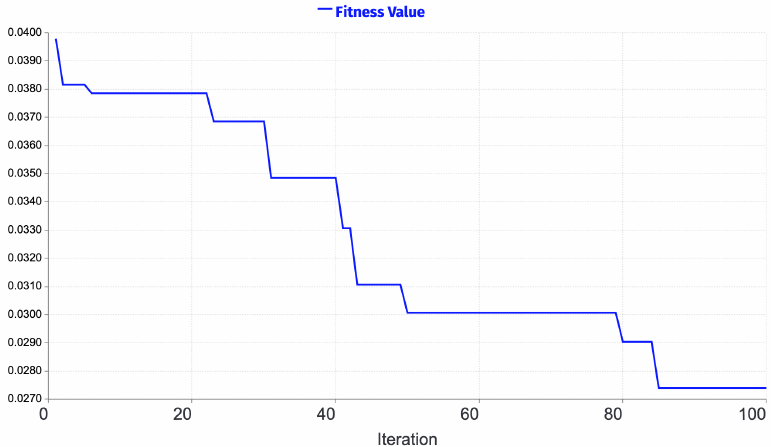
Figure A8. The training convergence curve when using the ANN with the PSO and the accuracy fitness function for the dataset of Taiwanese